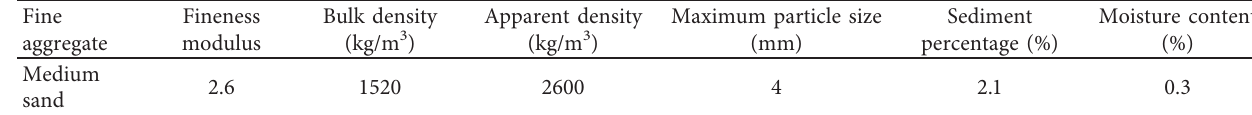
Figure 1: The grain grading curve of Table 1: The basic properties of sand.